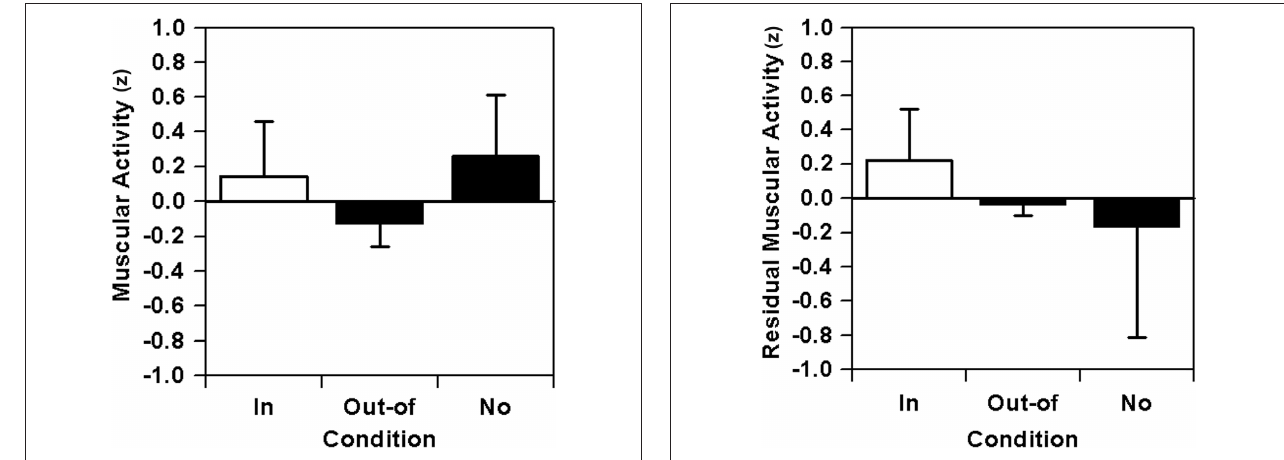
Figure 5 | Lever sequencing: relative muscular activity (eA) combined across the six nodal points as a function of focus of attention on the nodal point (in-focus), on any other nodal point (out-of-focus), or without any special instruction (no).